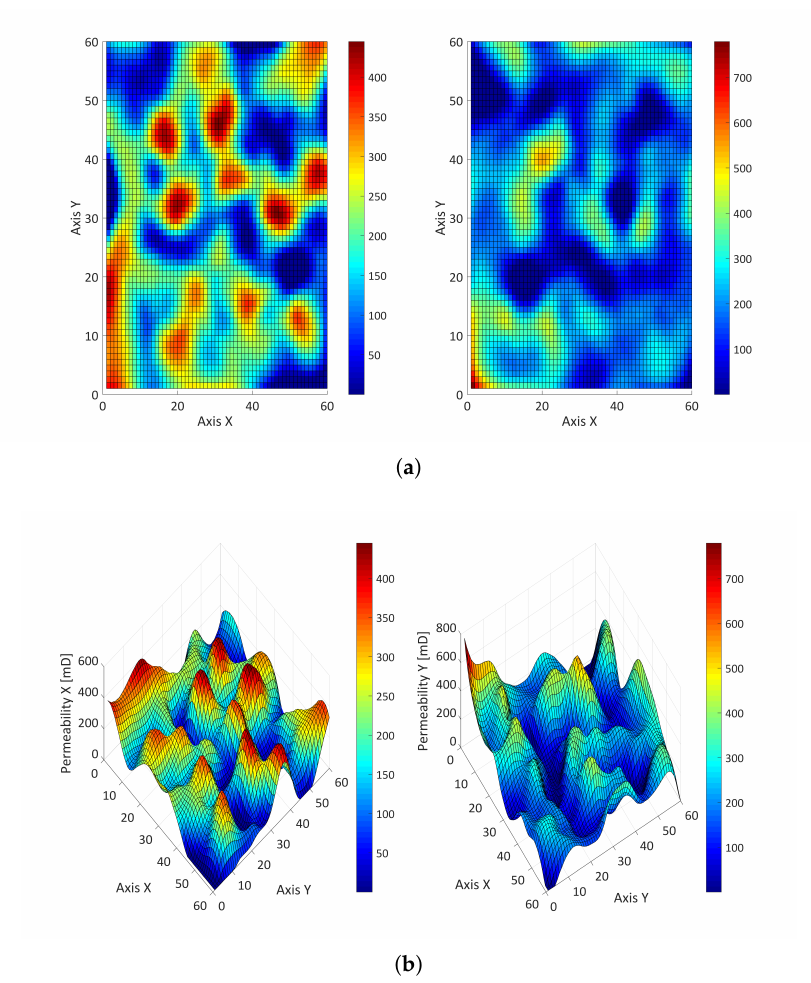
Figure 11. Permeability field (in mD) in the X (left) and Y (right) axes used to study the influence of the oil viscosity in the simulator (top view— a and perspective— b